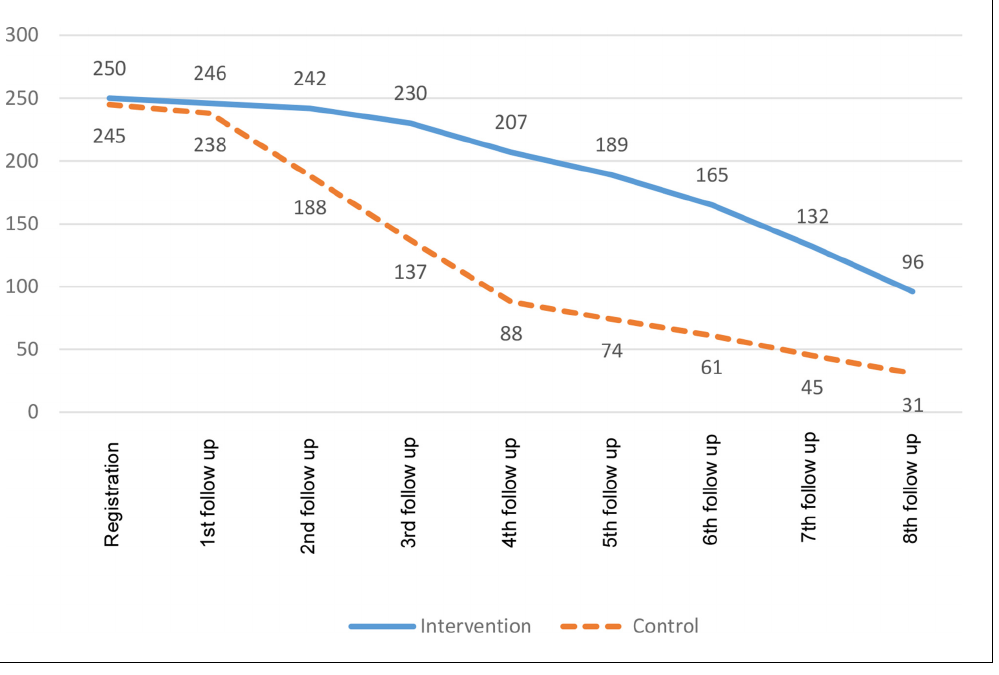
Figure 2 Patient attrition in intervention and control